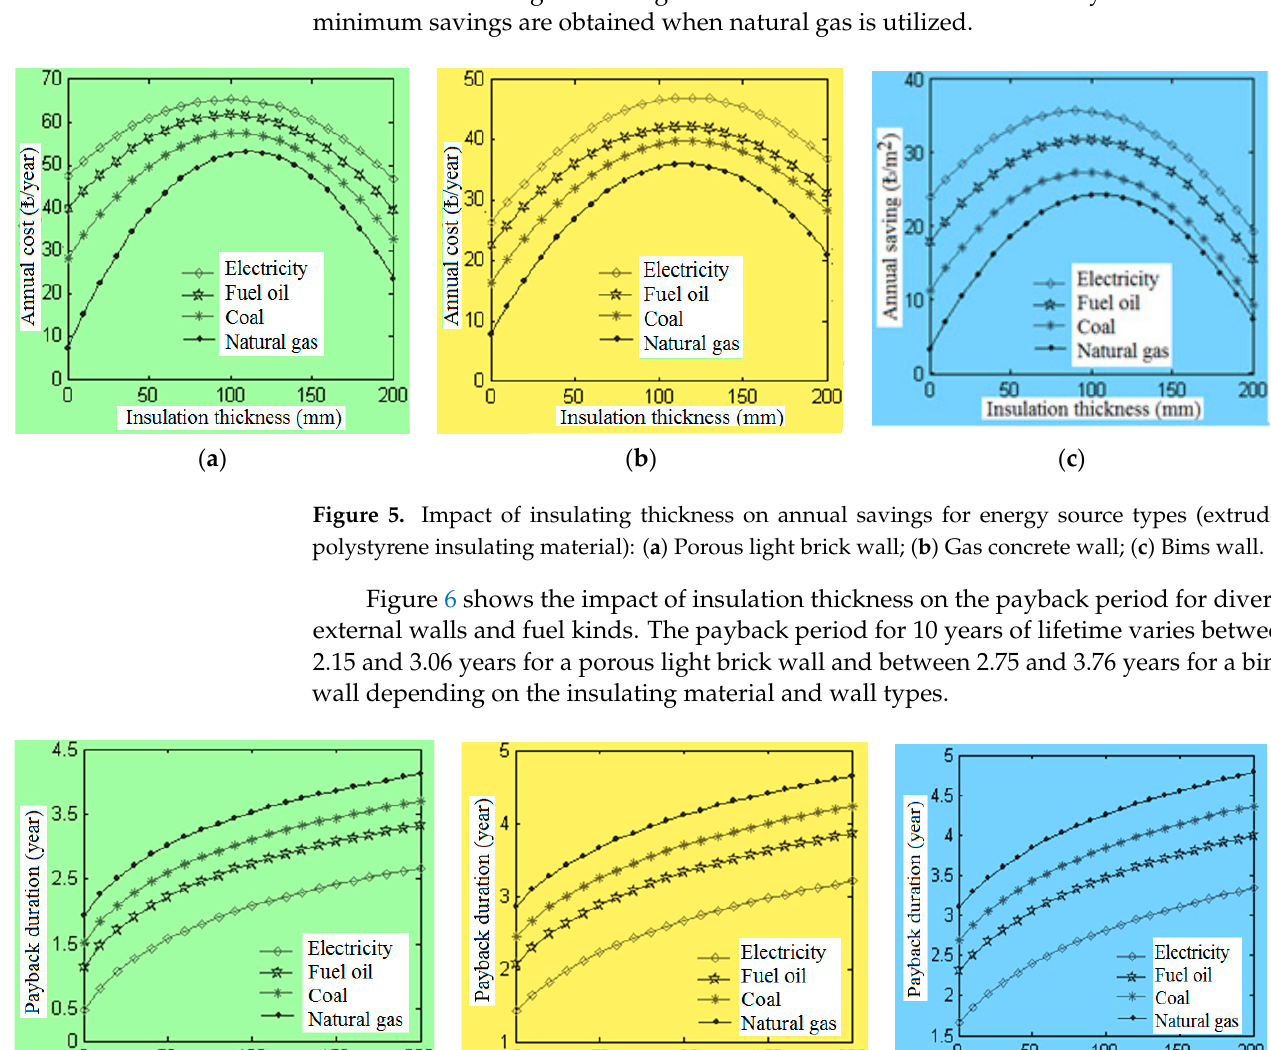
( c ) Figure 7. Correlation of CO 2 emission with insulation thickness for different fuel types: ( a ) Porous light brick wall; ( b ) Gas concrete wall; ( c ) Bims wall. ( a ) ( c ) Figure 8. Correlation of SO 2 emission with insulating thickness for diverse energy source types: ( a ) Porous light brick wall; ( b ) Gas concrete wall; ( c ) Bims wall. 3.2. Energy Consumption Analysis with Revit Simulation during One Year In this phase of the study, natural gas was taken into account as the energy source with the lowest emissions according to the first analysis. Later, when natural gas is used as an energy source for XPS and glass wool, the optimum insulation thicknesses obtained through mathematical modeling were selected as the applied thicknesses of the insulation